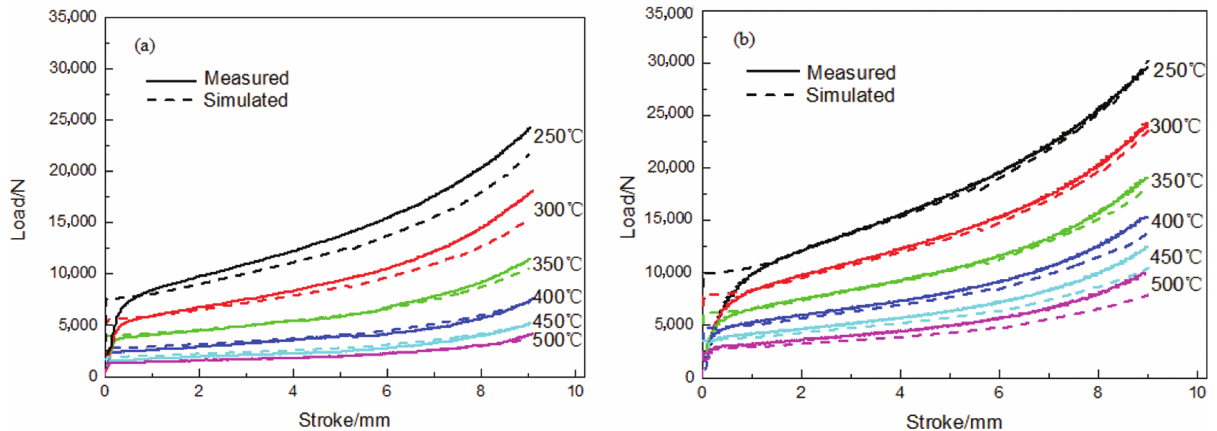
Figure 5: Measured and simulated load – stroke curves during hot compression: (a) 0.01 s − 1 and (b) 1 s − 1